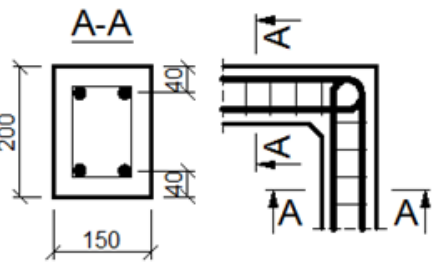
Figure 12. Geometry and main reinforcement for the case of elements with the same cross section heights; dimensions in (mm).